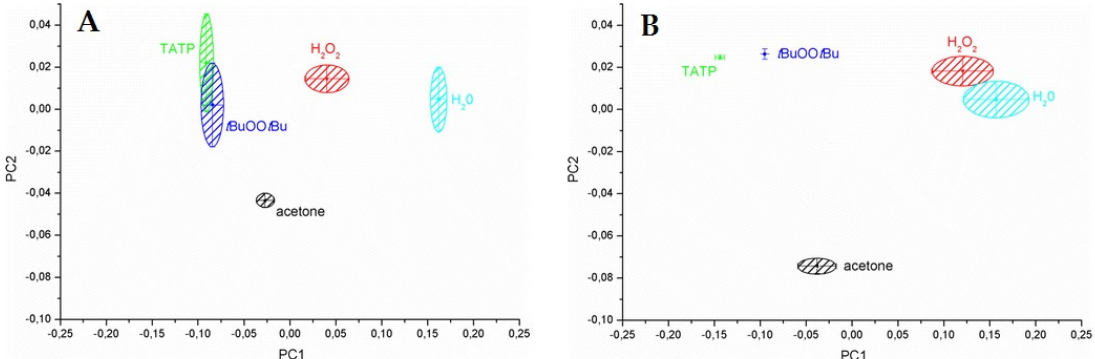
Figure 8. ( A ) PCA result of HFF-QCM sensor array for the detection of TATP without pretreatment, ( B ) PCA result of HFF-QCM sensor array for the detection of TATP after surface pretreatment, indicating that surface treatment resulted an improved TATP detection with better separation from interferents, adapted with permission from [166].